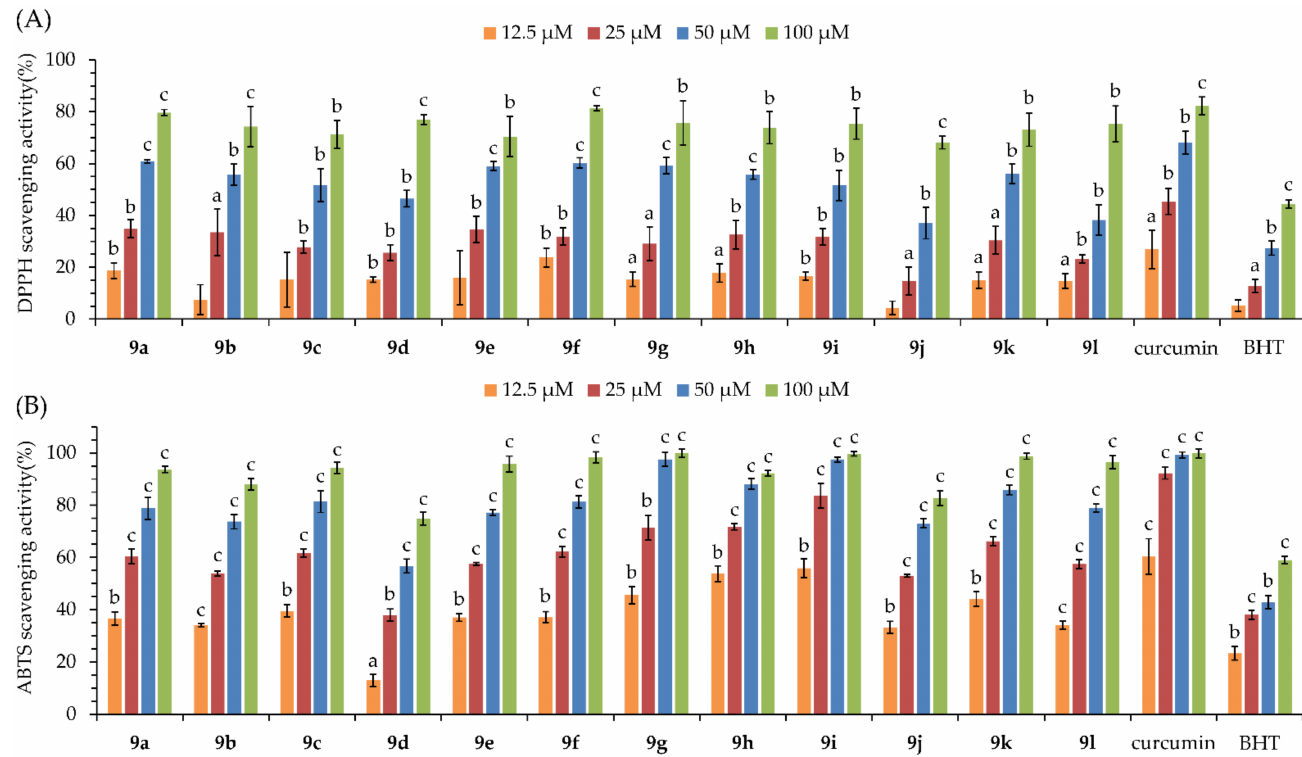
Figure 5. Bars show ( A ) DPPH and ( B ) ABTS radical scavenging activity at different concentrations (12.5, 25, 50, 100 µ M) of compounds 9a – l , curcumin, and BHT. Bars represent mean ± SD of three experiments. Bars marked with different letters are significantly different ( a p < 0.05; b p < 0.01; c p < 0.001 compared to control). Table 2. DPPH and ABTS radical scavenging activity of compounds 9a – l , curcumin and BHT.